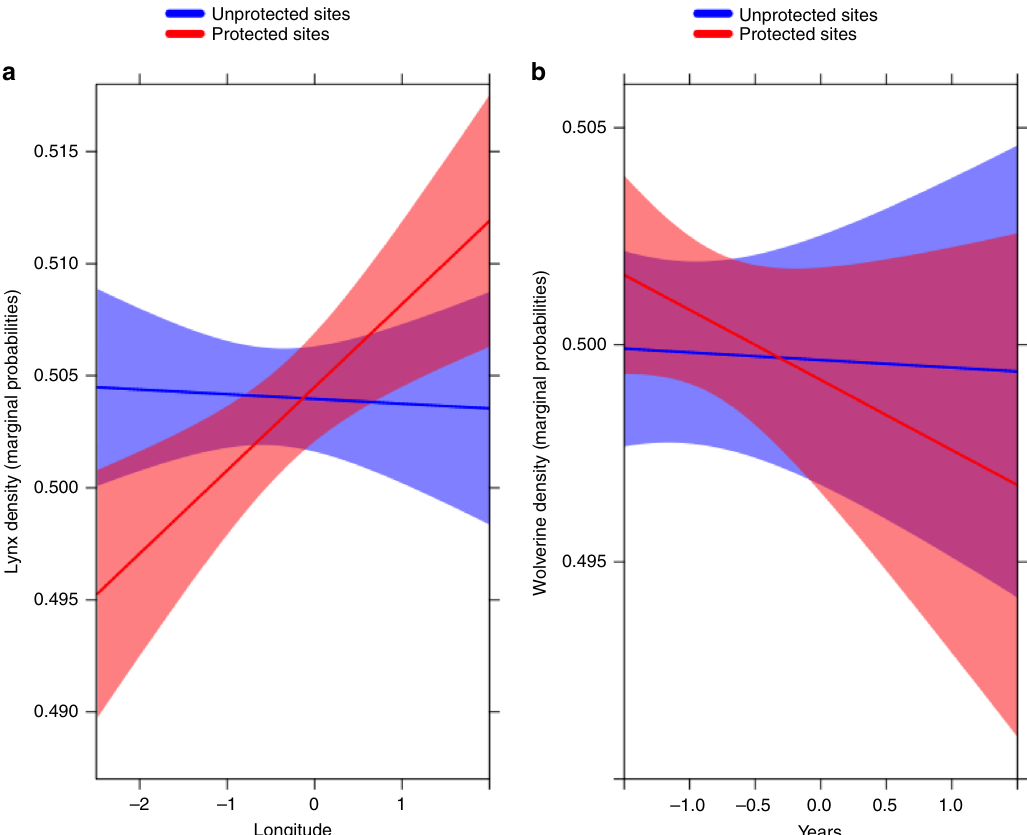
Fig. 4 Spatio-temporal variation in effectiveness of the Finnish PA network. Predicted values (solid lines) and 95% con fi dence intervals (shaded areas) of ( a ) lynx and ( b ) wolverine densities in relation to longitude and years, respectively, for sites included inside the Finnish PA network and sites located outside protected